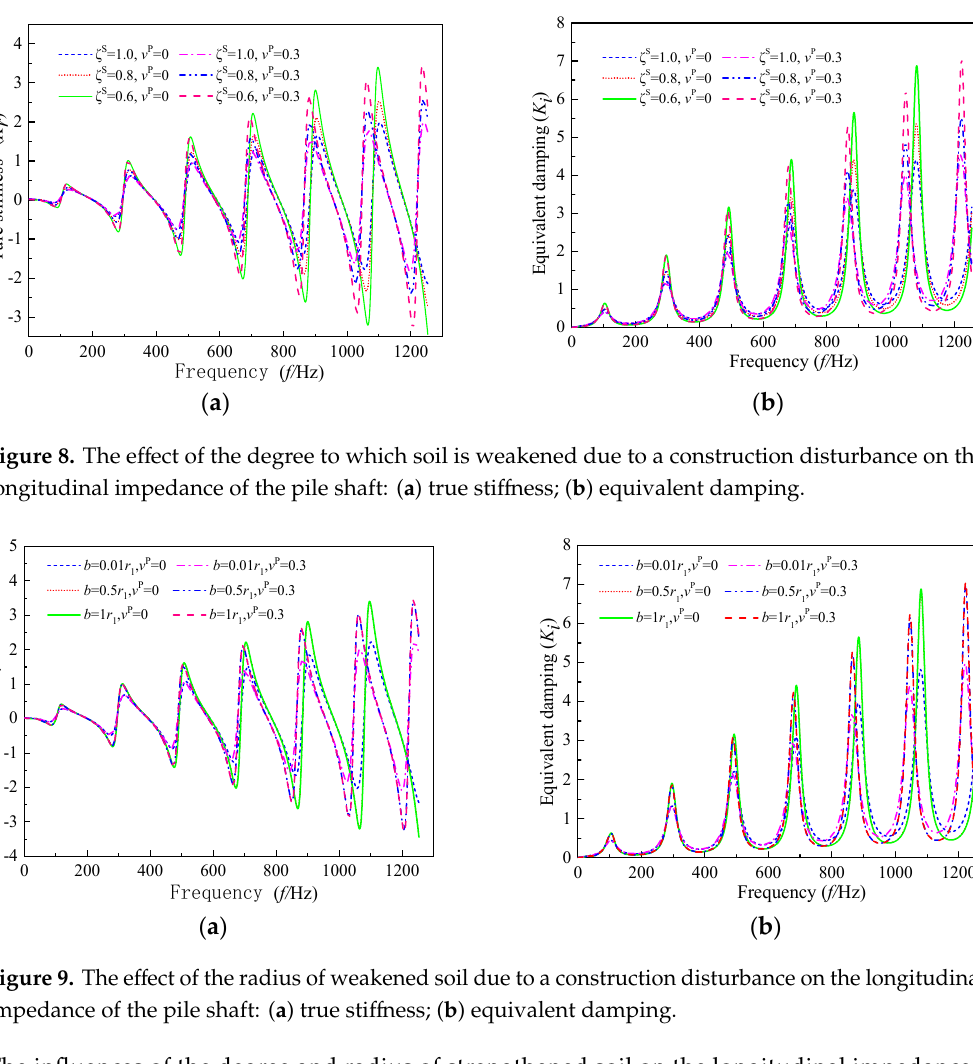
( b ) Figure 7. The effect of the viscous damping coefficient on the longitudinal impedance of the pile shaft: ( a ) true stiffness; ( b ) equivalent damping. Figures 8 and 9 depict the effect of the degree and radius soil is weakened due to a construction disturbance on the longitudinal impedance at the head of the pile shaft, respectively. It